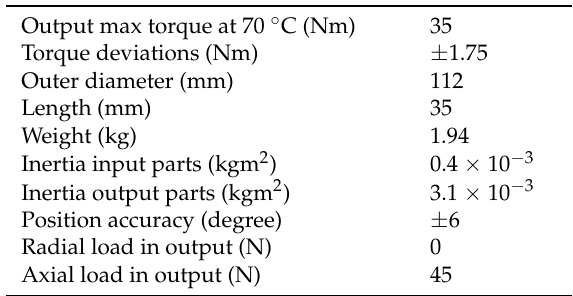
Table 1. Maximum working temperature of permanent magnets.